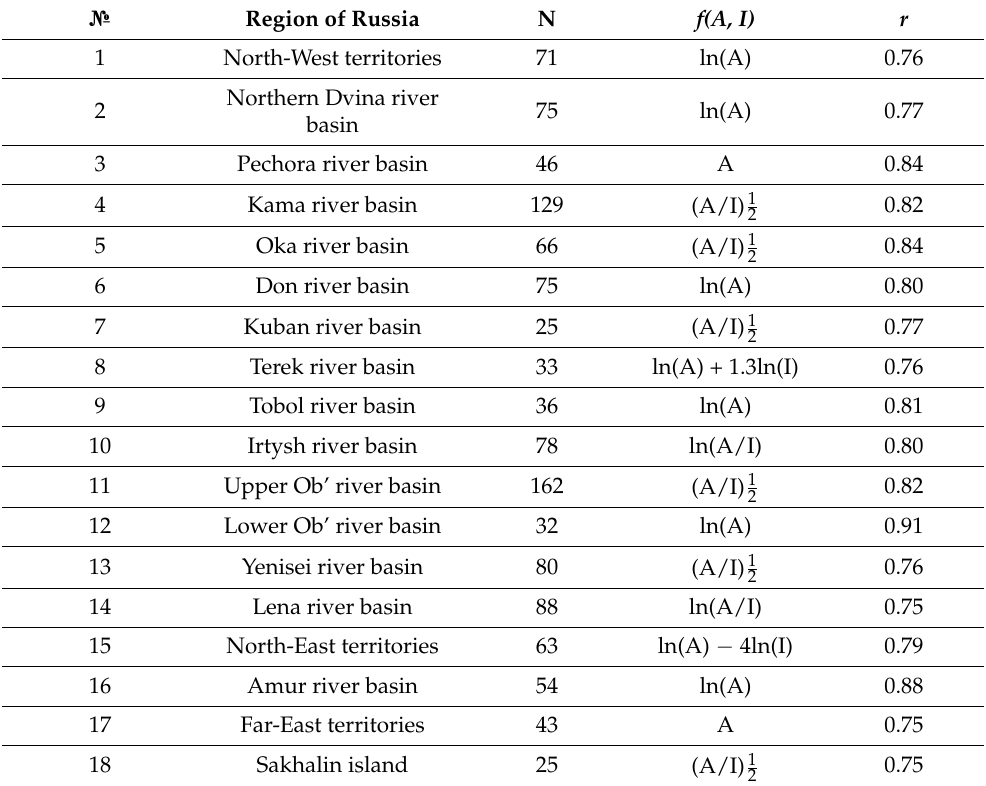
Table 5. Characteristics of the selected regions.